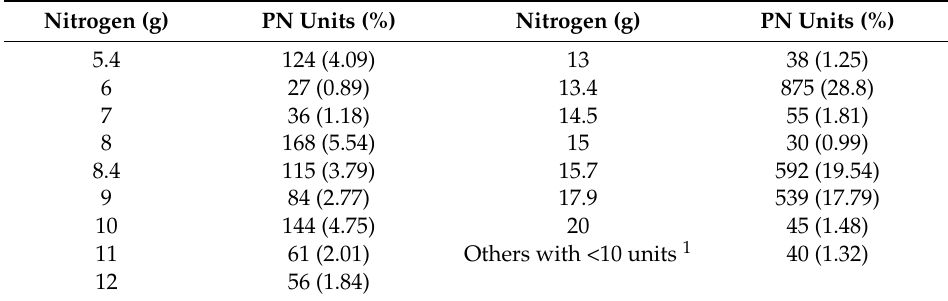
Table 1. Parenteral nutrition units prescribed according to nitrogen quantity.